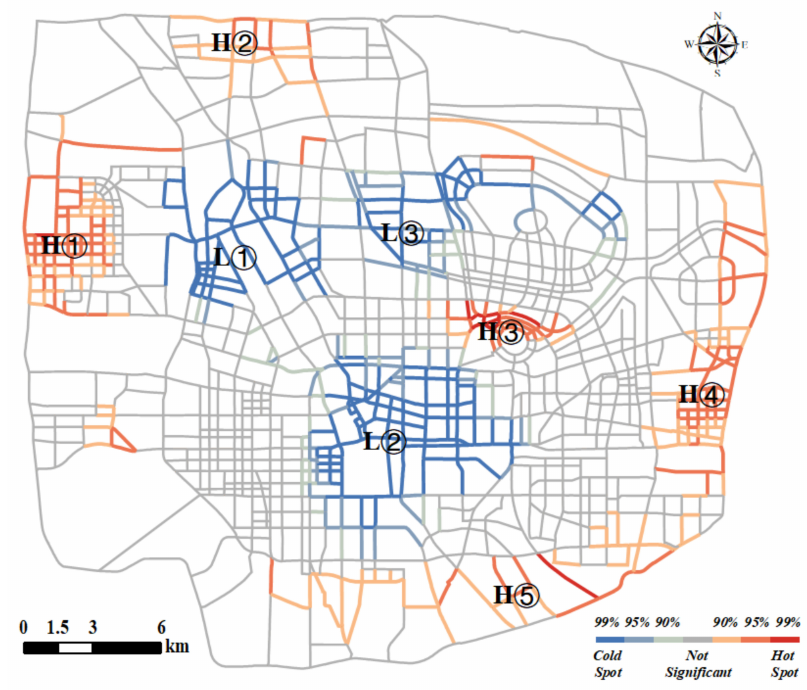
Figure 7. The hot and cold spot area of road